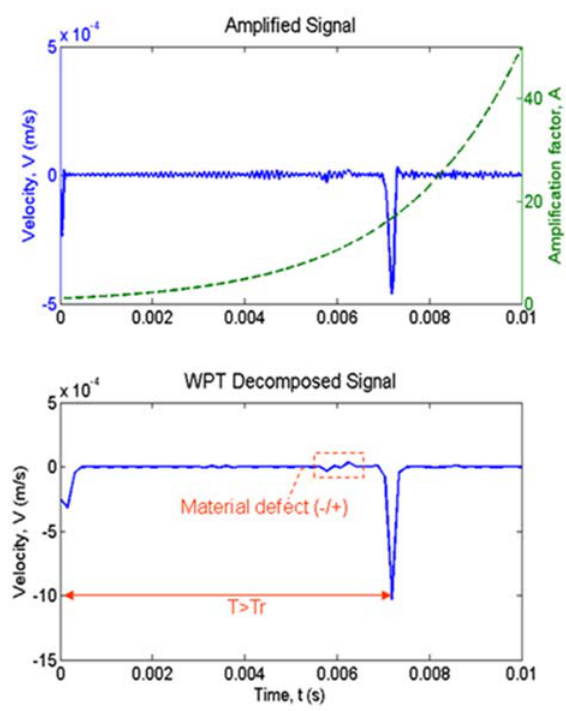
Figure 13. Amplified and WPT decomposed velocity signal for case c of dataset 6 (pile with low-quality concrete segment).